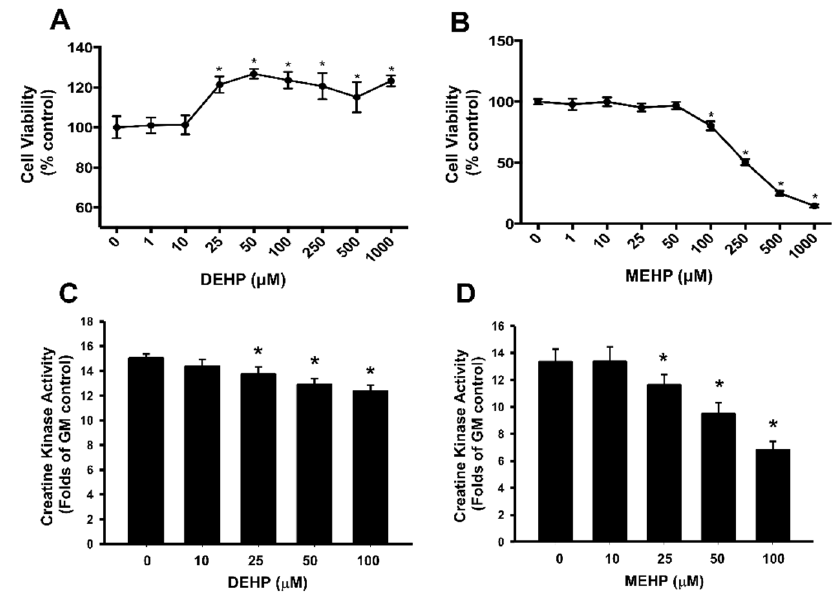
Figure 1. The changes in cell viability and creatine kinase activity in myoblasts treated with both DEHP and MEHP. Under differentiation medium, C2C12 cells treated with DEHP ( A , C ) or MEHP ( B , D ) (1–1000 μ M) for 24–96 h were observed. MTT assay was performed to analyze cell viability ( A , B ). Creatine kinase activity was assayed using a commercial kit ( C , D ). GM indicated as growth medium. Data are presented as means ± SEM (three independent experiments, triplicate repeats in each); p < 0.05 indicates significance compared to the control (*).